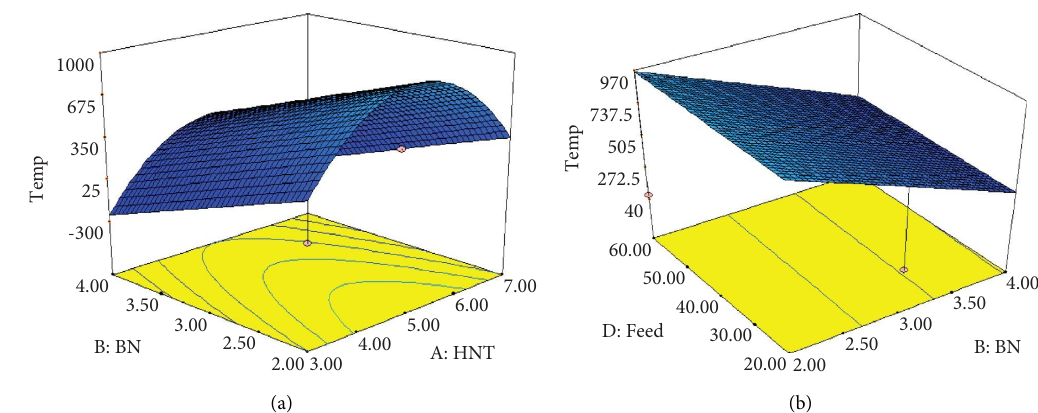
Figure 4: (a) Efect of temperature on HNT vs. BN. (b) Efect of temperature on feed vs. BN.